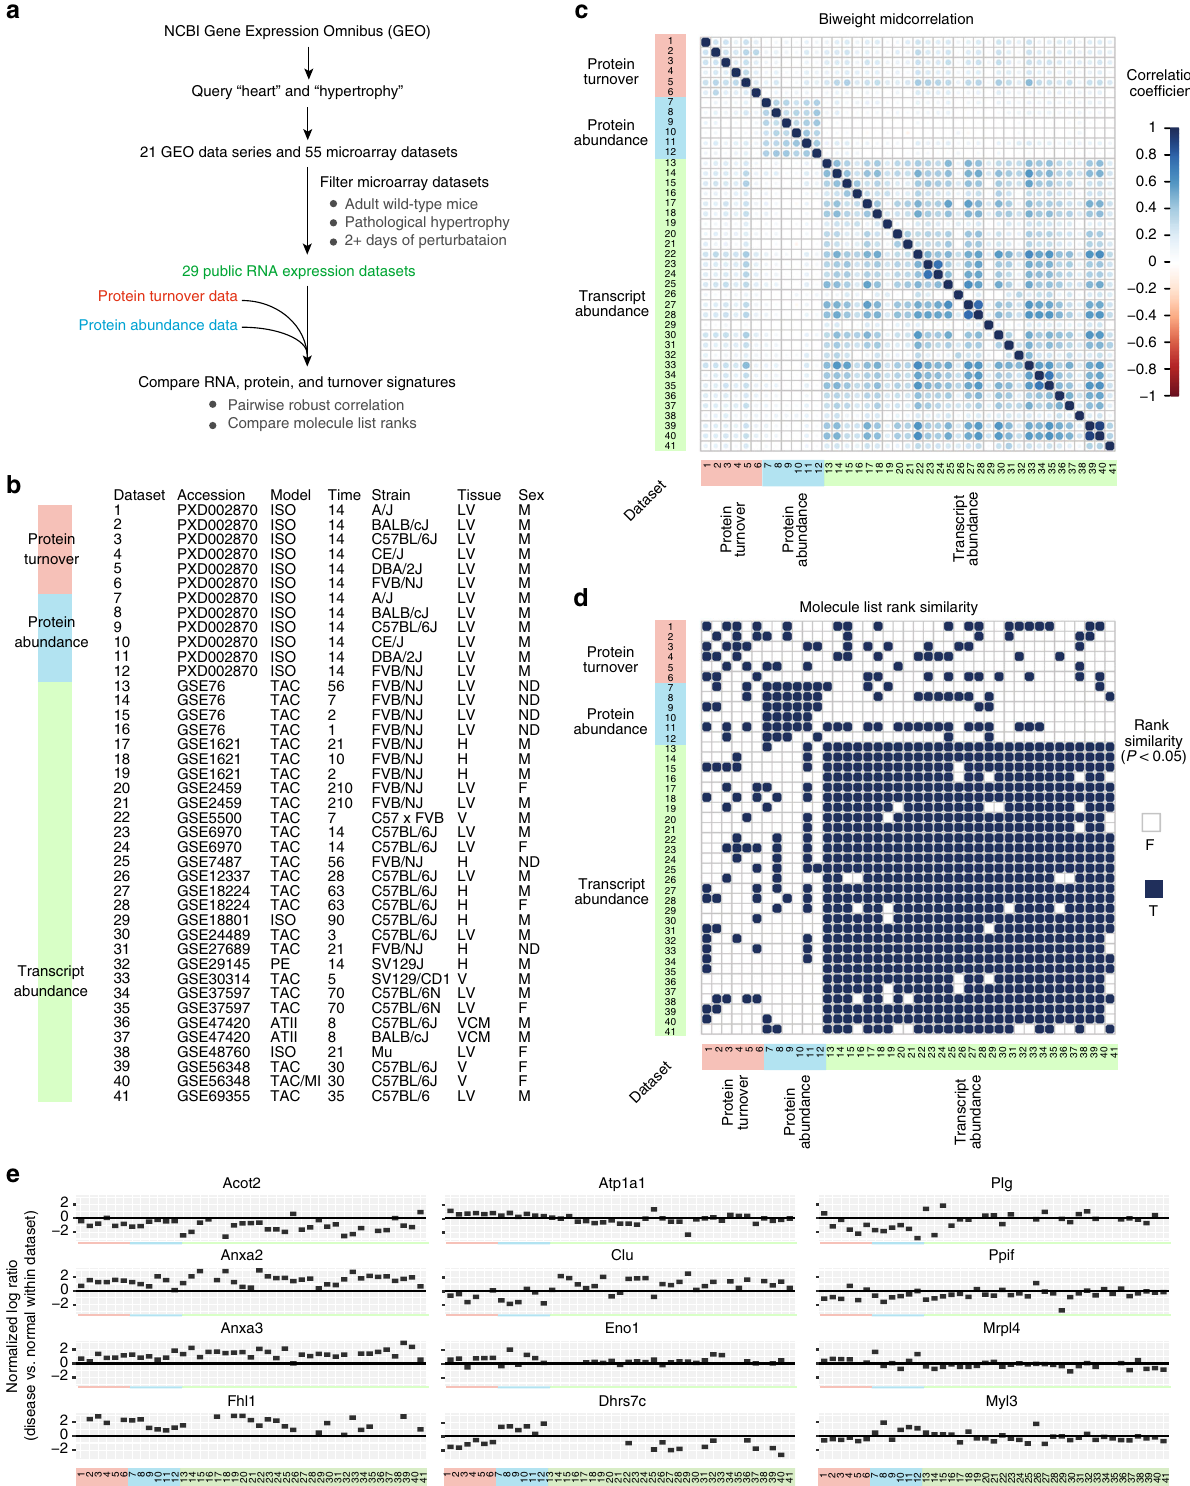
signatures21 GEO data series and 55 microarray